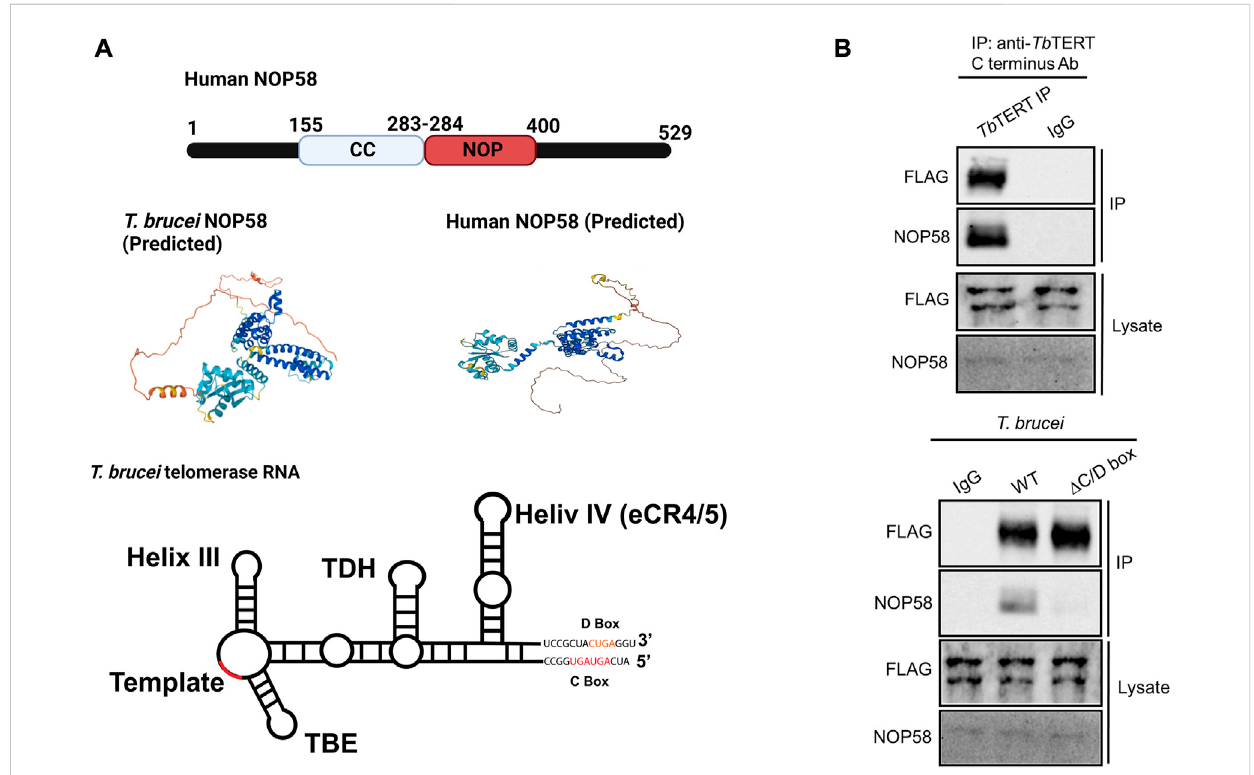
FIGURE 4 NOP58interactswiththe T.brucei telomerasecomplex. (A) DomainstructureofhumanNOP58.Predictedsecondarystructuremodelsfor T.brucei and human NOP58 obtained from AlphaFold (Jumper et al., 2021)Predicted proteinstructures areshowninthe sameorientation. Darkbluerepresents a very high model con fi dence (pLDDT > 90), light blue con fi dent (90 > pLDDT > 70), yellow low con fi dence (70 > pLDDT > 50), orange very low con fi dence (pLDDT < 50). Secondary structure model of T. brucei telomerase RNA. The C/D box binding motif is highlighted. [ (B) , top] Co-IP assay using WT T. brucei celllysate.IPantibody:anti- Tb TERTCterminus;Westernblotantibodies:anti-FLAGandanti-NOP58.[ (B) ,bottom]Co-IPusingbothWTand Δ C/D